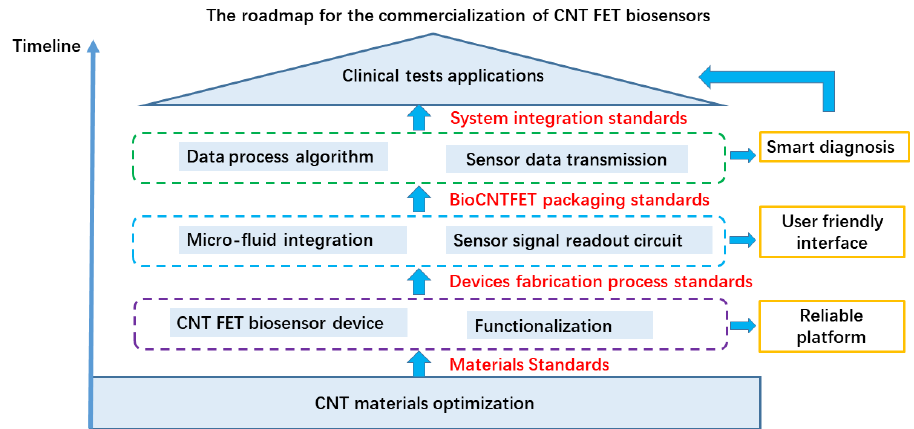
Figure 10. Schematic representation of the carbon nanotube-based biosensor field effect transistor industrialization process.